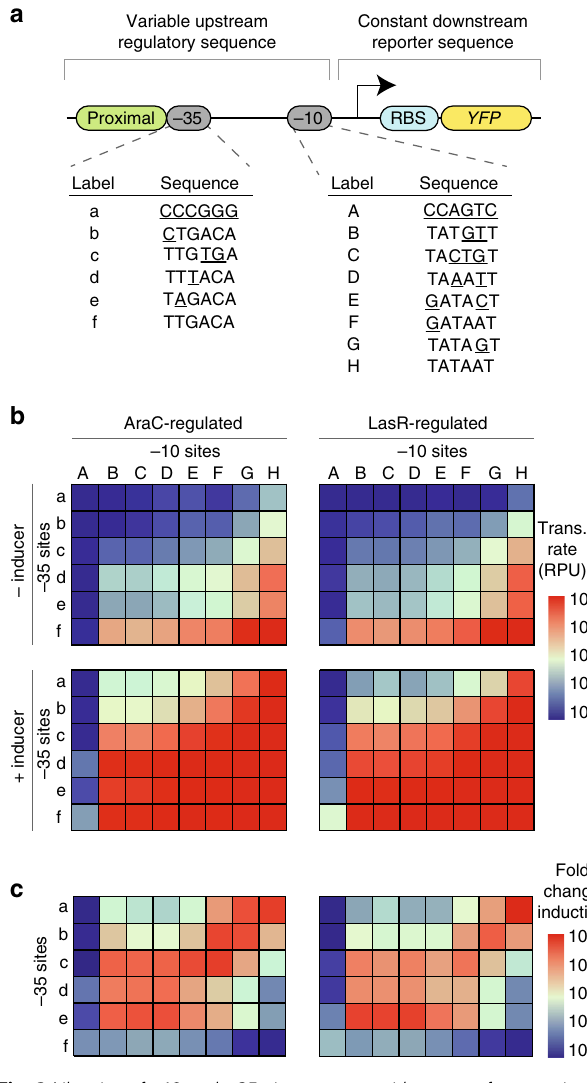
Fig. 2 Libraries of − 10 and − 35 sites cover a wide range of expression. a Diagram of the promoters showing essential features. Each promoter contained a proximal operator site for either AraC or LasR, a constant downstream reporter (YFP), and − 10 and − 35 sites chosen from the lists below. In each list, bases that do not match the consensus sequence are underlined. b Experimentally measured transcription rates of promoters regulated by either AraC (left column) or LasR (right column) with (bottom row) and without (top row) inducer for every combination of the − 10 and − 35 sites listed in a . c Fold-change induction heat maps for either AraC (left column) or LasR (right column). Experiments were performed